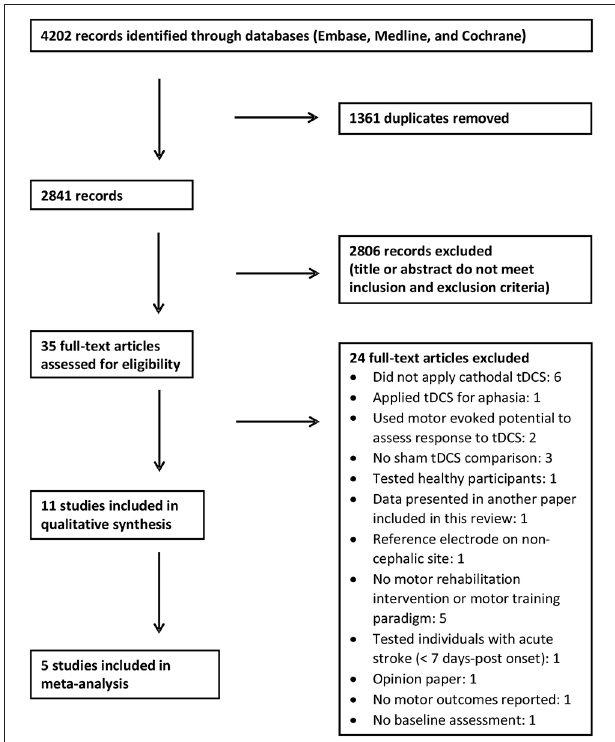
FIGURE 1 | Flow chart depicting the study